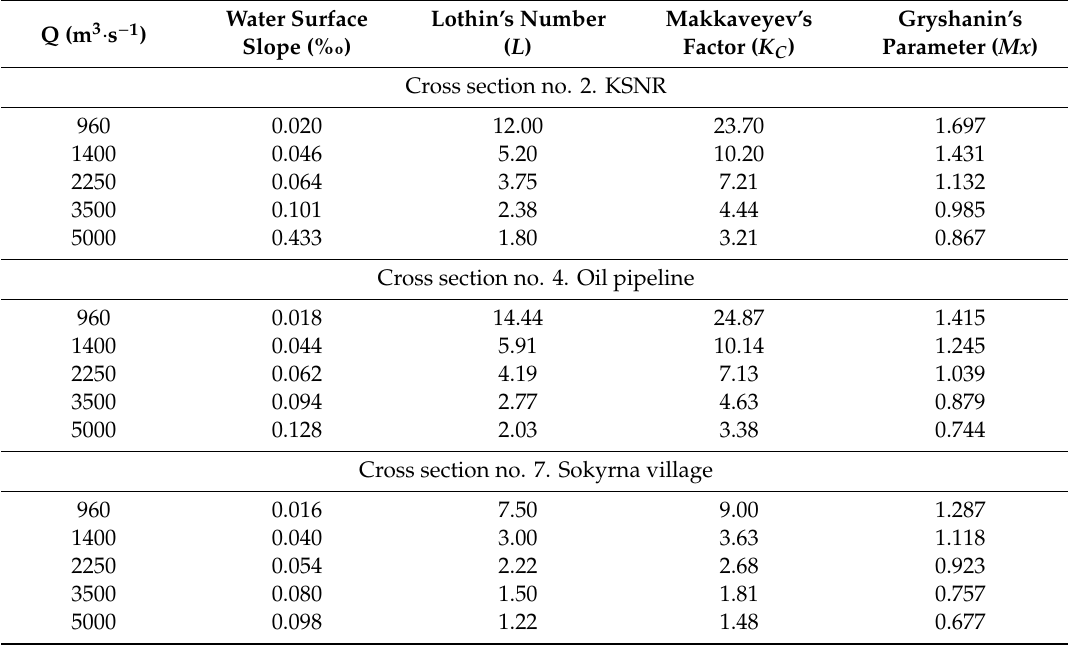
Table 4. Morphological indicators * of the Dnieper channel stability downstream of the Kaniv HPP during di ff erent water discharge conditions and related hydraulic